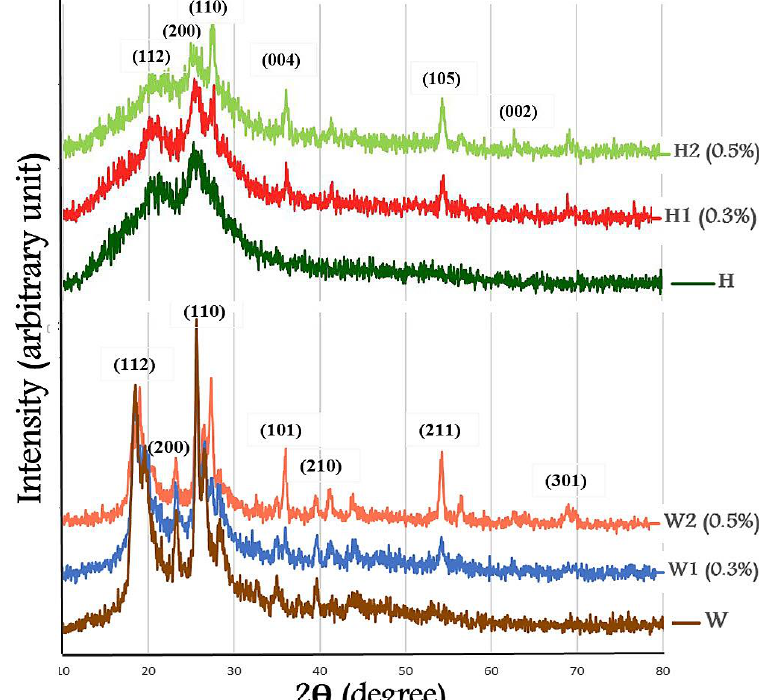
Figure 4: XRD patterns of the pure PANI with H